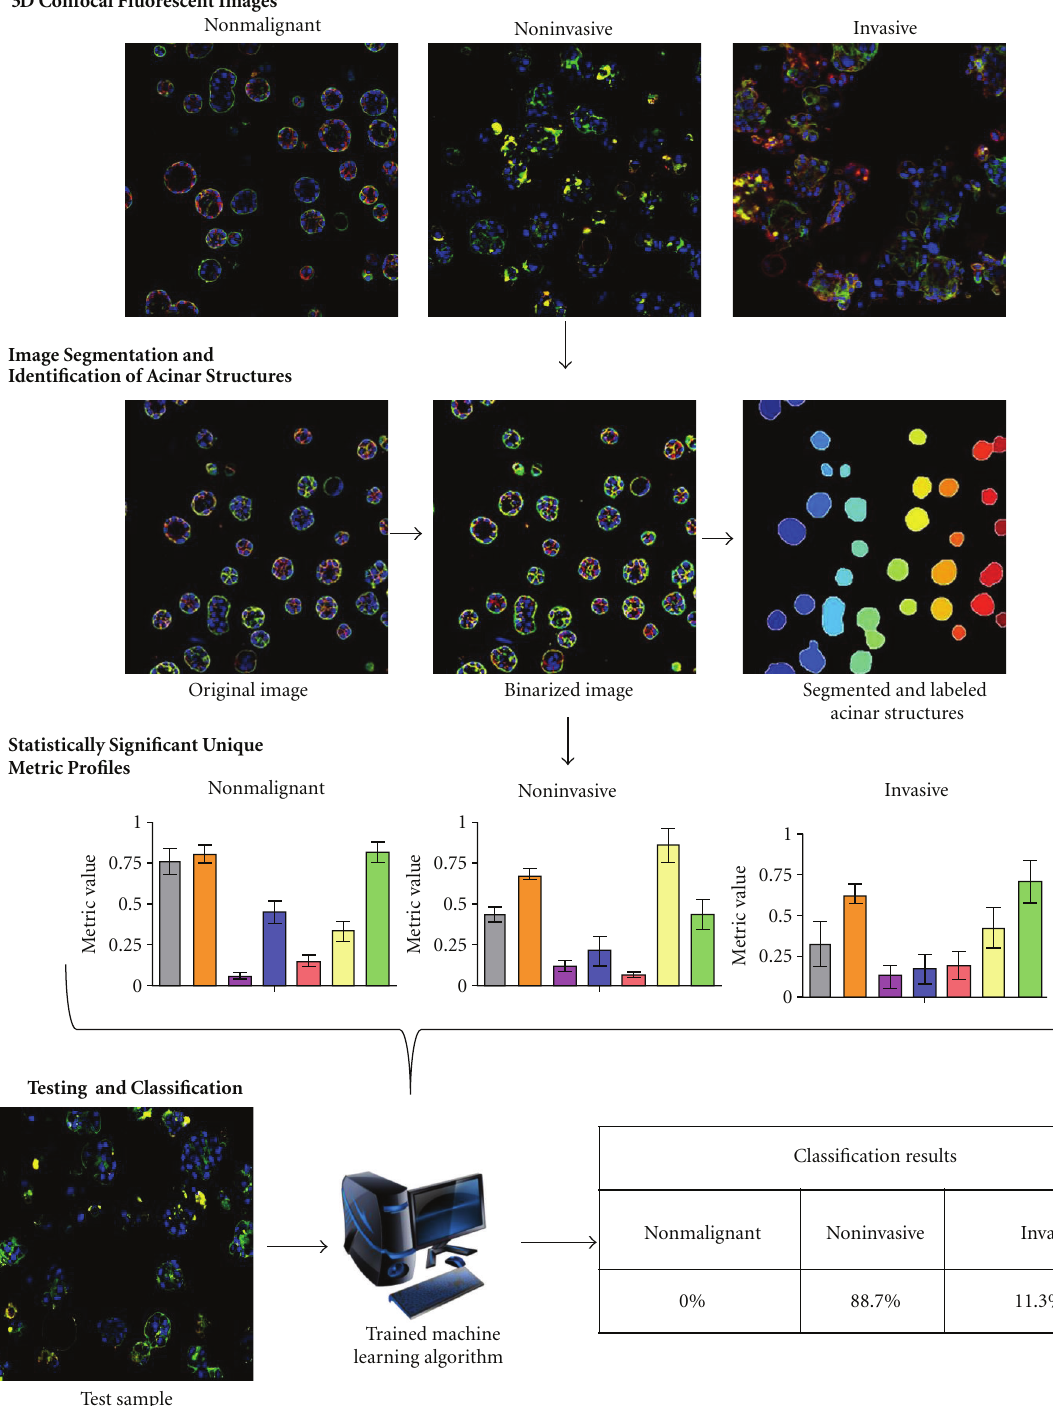
Figure 8: A flow chart of the proposed quantitative analysis approach in measuring morphological-based features of acini. First, fluorescently labeled images of the cultures are captured by 3D confocal microscopy. Next, individual acinar structures in these images are segmented and labeled. We then extract the proposed features based on the acini morphology that lead to statistically significant unique feature profiles between functionally di ff erent stages of cancer. Finally, automated grading of cancer is achieved by supervised machine